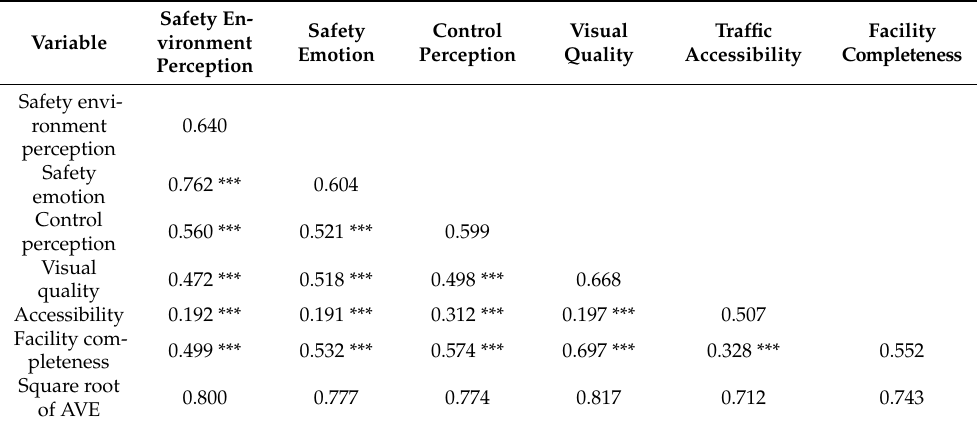
Table 5. Discriminant validity and the correlations of variables.